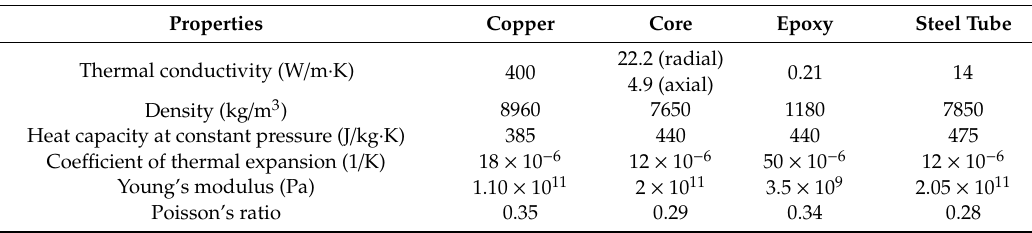
Table 2. Material properties used in the simulations.